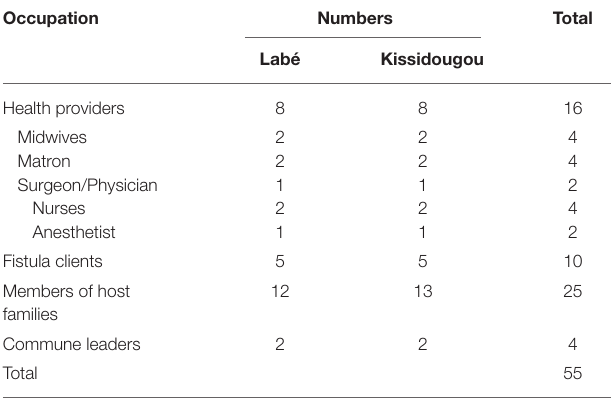
TABLE 1 | Profile of participants interviewed, Kissidougou and Labé, Guinea, 2015.